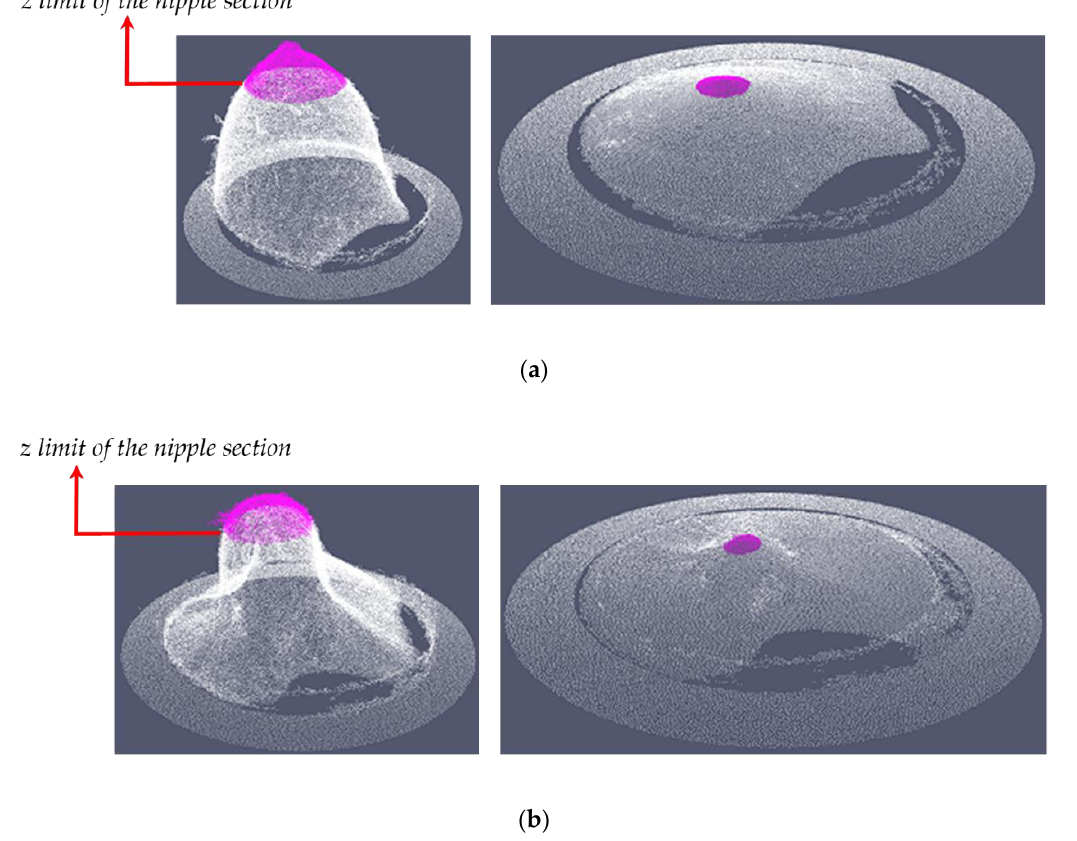
Figure 18. Nipple section (magenta points) in the not stretched point cloud (left-hand images) and in the stretched point cloud 𝑃𝑐 𝐶 (right-hand images): ( a ) point cloud corresponding to Patient 002; ( b ) point cloud corresponding to Patient